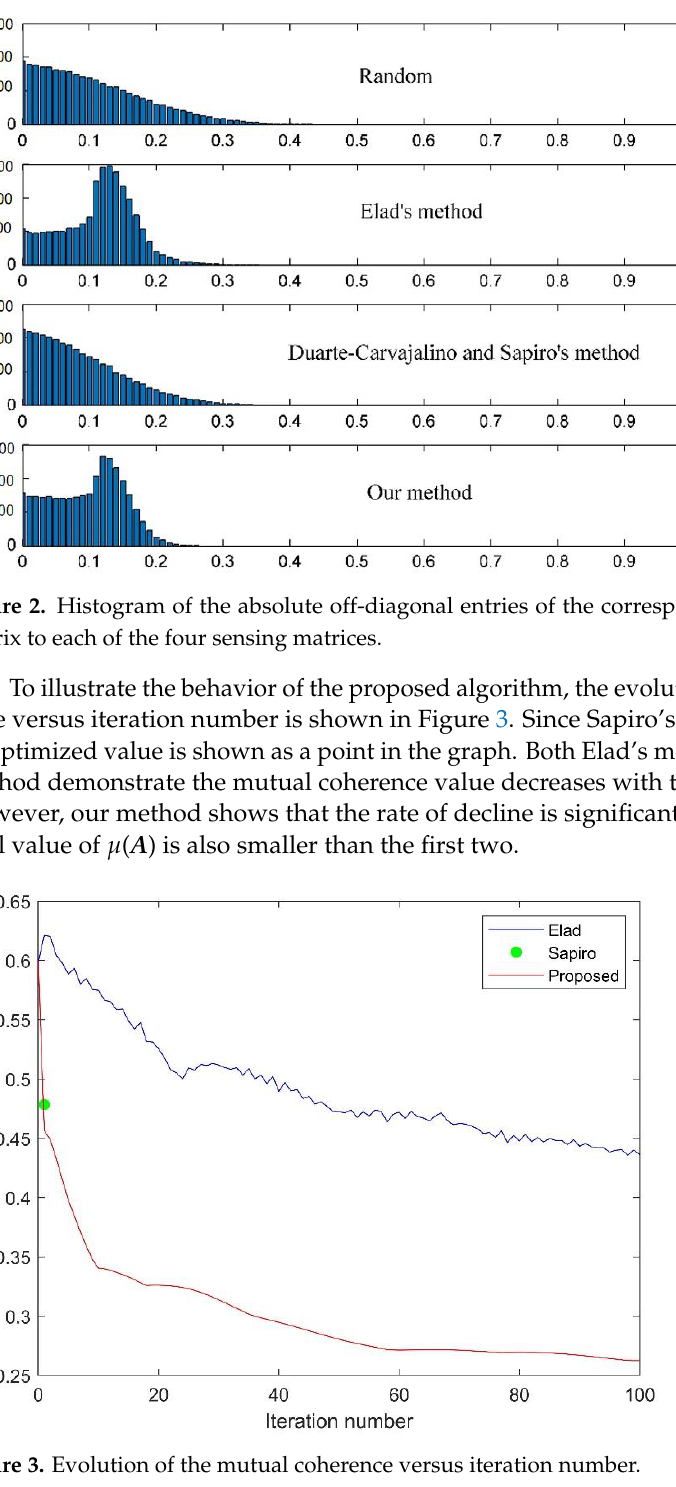
Figure 3. Evolution of the mutual coherence versus iteration number.